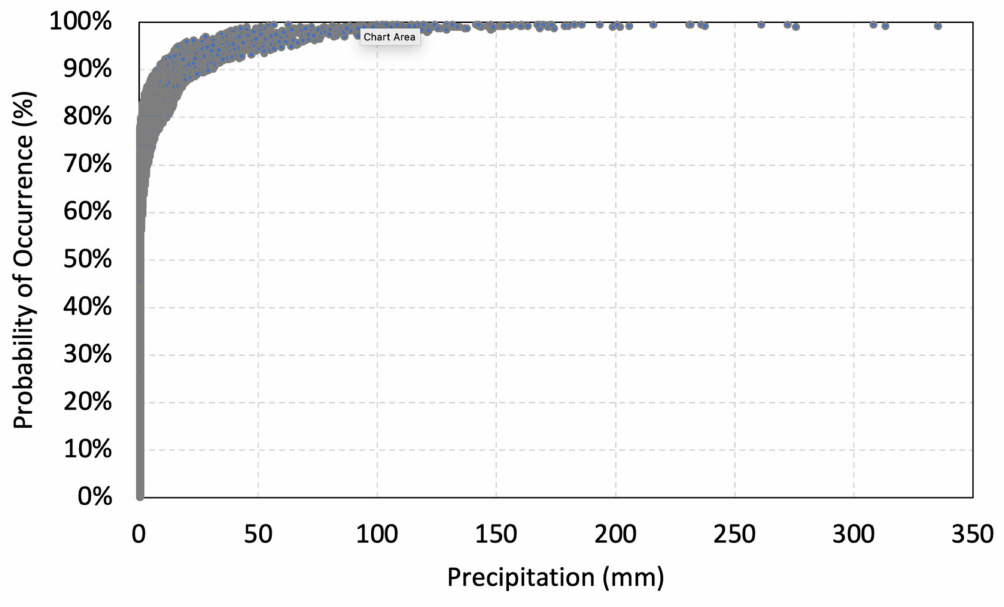
Figure 4. Weibull plotting position of all collected daily rainfall data for the years 1975 to